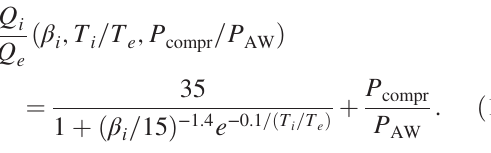
FIG. 2. Top row: power spectra of the electric and magnetic fields normalized by ρ magnetic energy. Second row: ratios of compressive-field spectra to the perpendicular-magnetic-field spectrum. The horizontal lines correspond to the theoretical predictions for KAWs [29] [dotted lines for Eq. (15) and dashed lines for Eq. (16)]. Third row: spectrum of the ion heating rate normalized by ρ integrated up to k ⊥ and normalized by Q left to right. The gray shaded region contains the corner modes in the ð k from simulations done in the “ fiducial ” and “ double-sized ” boxes, respectively (see Sec.